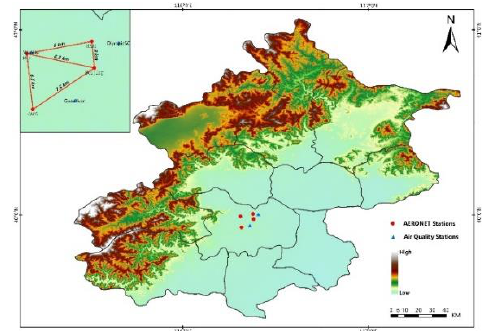
Figure1. Digital Elevation Model (DEM) image regarding AEONET (Aerosol Robotic Network) and ground air quality monitoring stations in Beijing; PKU: Beijing_PKU site, CAMS: Beijing_CAMS site and RADI: Beijing_RADI